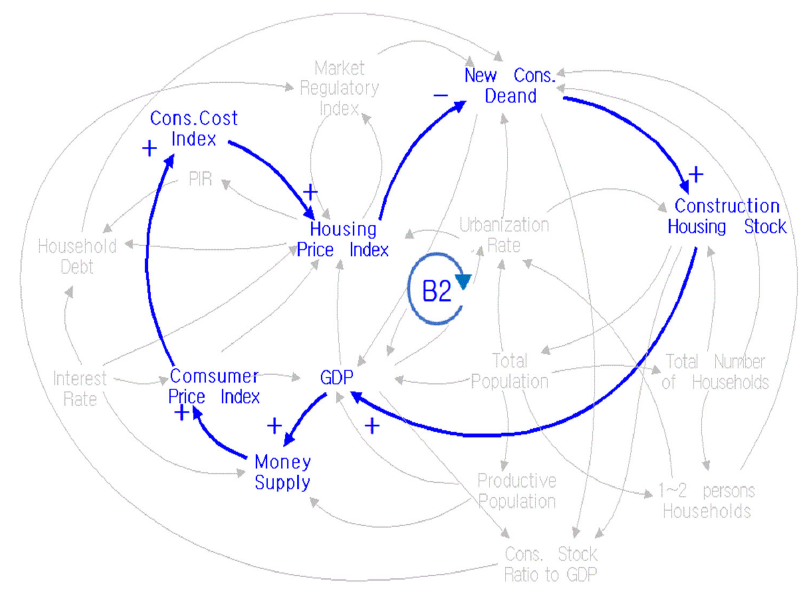
Figure 3. Loop of impact in the money volume in the residential construction market.